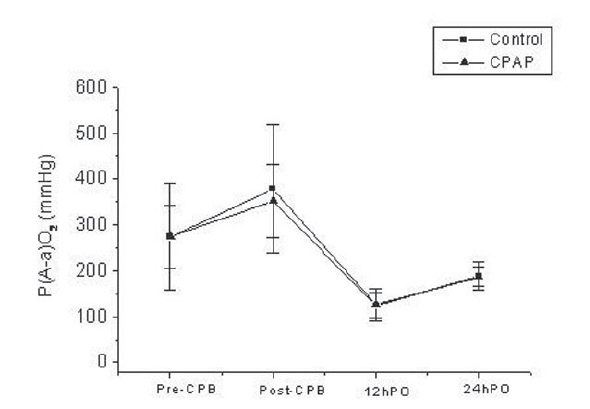
Fig. 3 – P(A-a)O (mmHg) at different observation times. - P(A- 2 a)O (mmHg) at different observation times. Statistically 2 significant differences were found between times for both